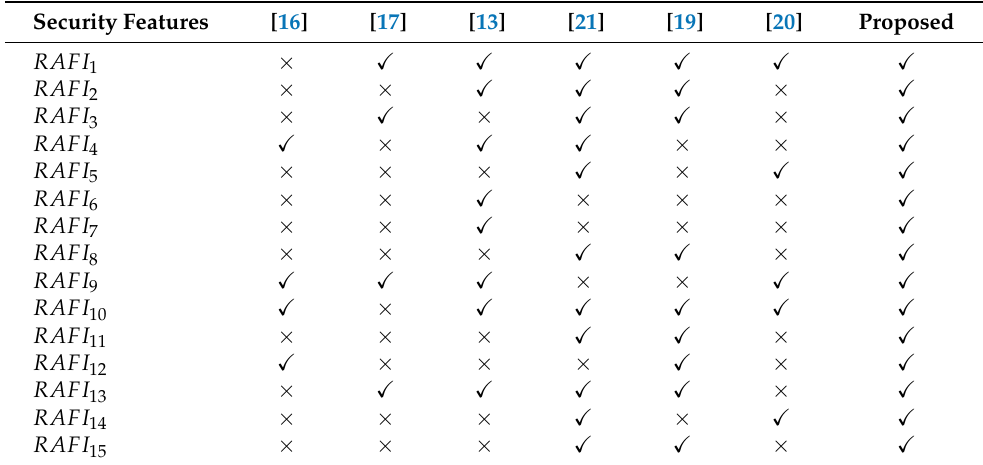
Table 8. Comparison security and functionality features.